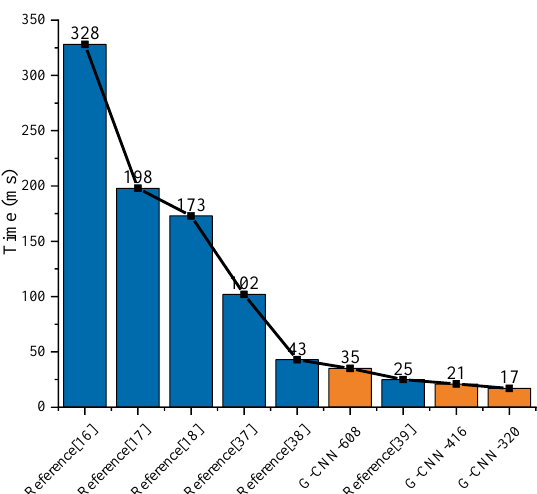
Figure 23. The ship detection time of different references.